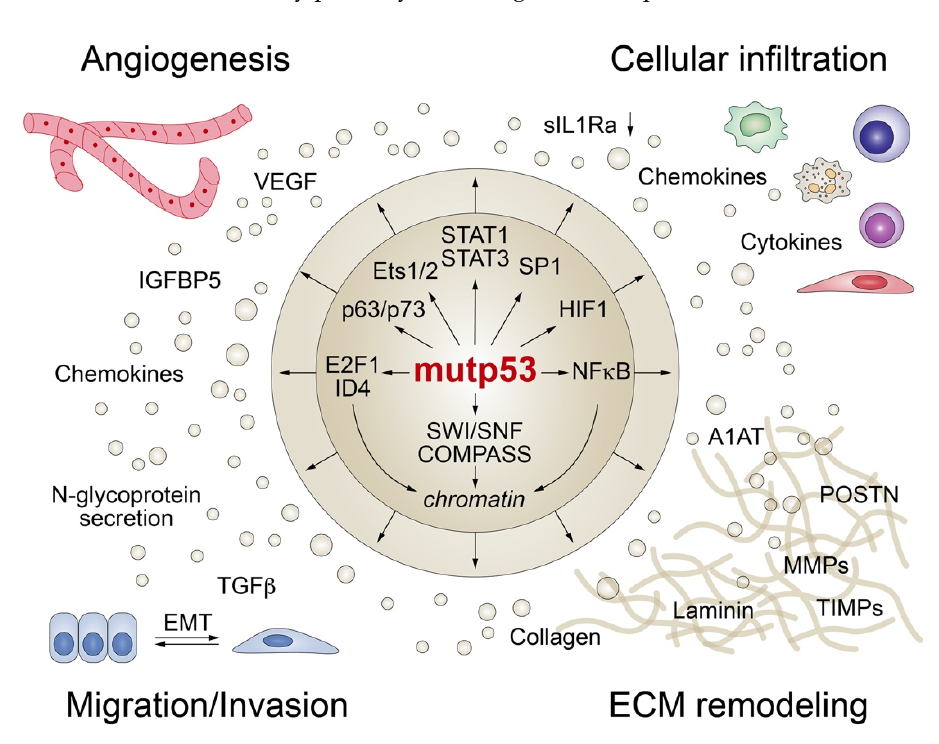
Figure 4. Mutant p53 shapes the tumor cell secretome at the transcriptional level. Mutant p53 interacts with transcription factors and/or chromatin ‐ modifying enzymes (SWI/SNF and COMPASS) to promote angiogenesis, trigger epithelial ‐ mesenchymal transition (EMT), remodel the extracellular matrix (ECM), and modulate the composition and function of the cellular stroma infiltrate.